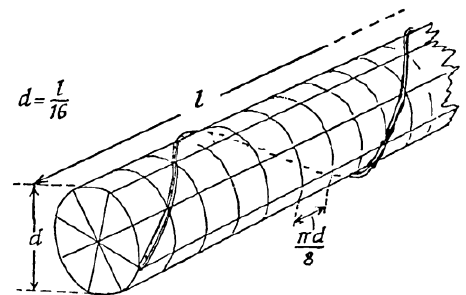
Figure 7. The endless screw of Archimedes based on the description of Vitruvius [54,55].